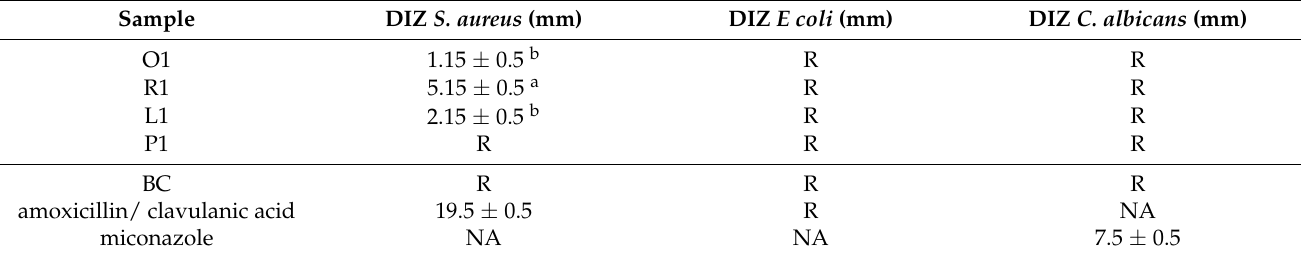
Table 6. Antimicrobial activity of bacterial cellulose enriched with parsley, lovage, rosemary, and oregano extracts against S. aureus , E. coli , and Candida albicans